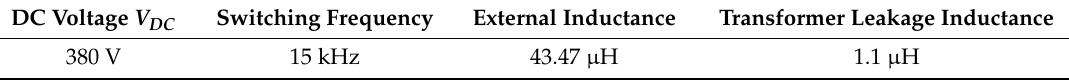
Table 1. Parameters of the 380-V TAB converter used in the DC power distribution